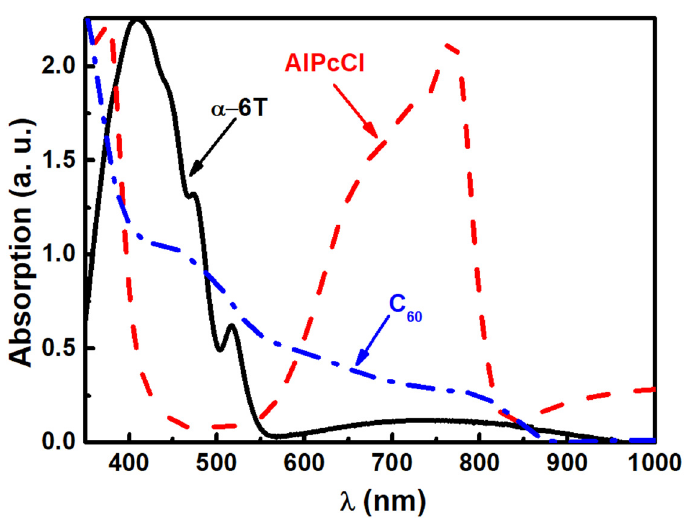
Figure 4. Absorbance spectra of α -6T (—), AlPcCl (— —) and C 60 (— • —).